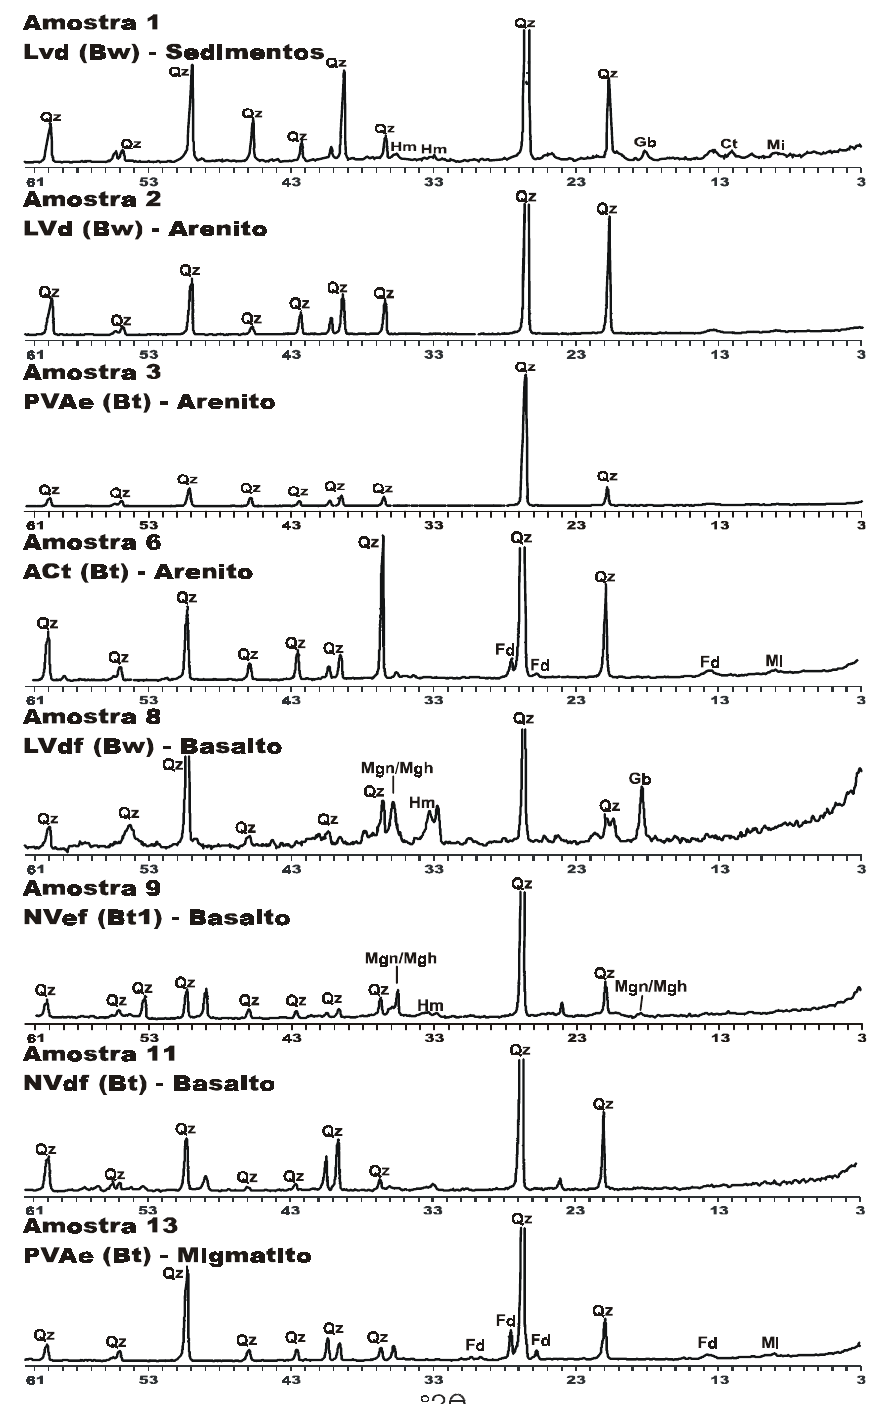
Figura 1. Difratogramas de raios-X de amostras representativas da fração areia total, apresentando os seguintes minerais: Ct - caulinita, Fd - feldspato potássico, Gb - gibbsita, Hm - hematita, Mgn/Mgh - magnetita/maghemita, Mi - mica e